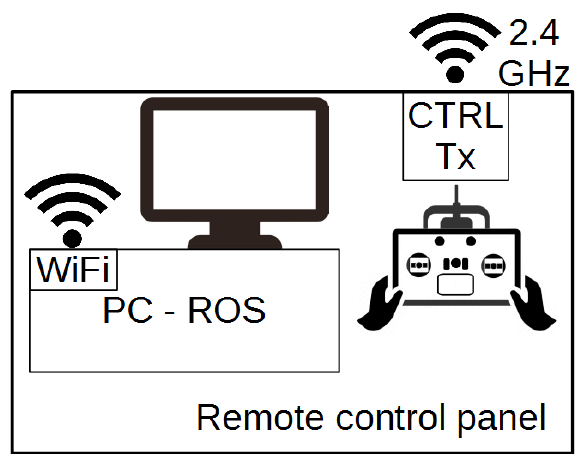
Figure 9. The remote control panel of mobile robot.